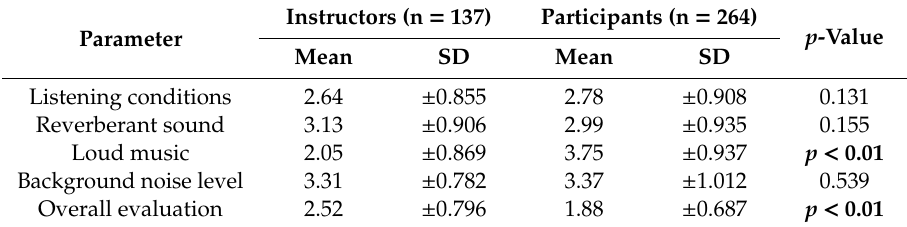
Table 7. Results of acoustic comfort parameters of instructors’ and participants’ opinions.